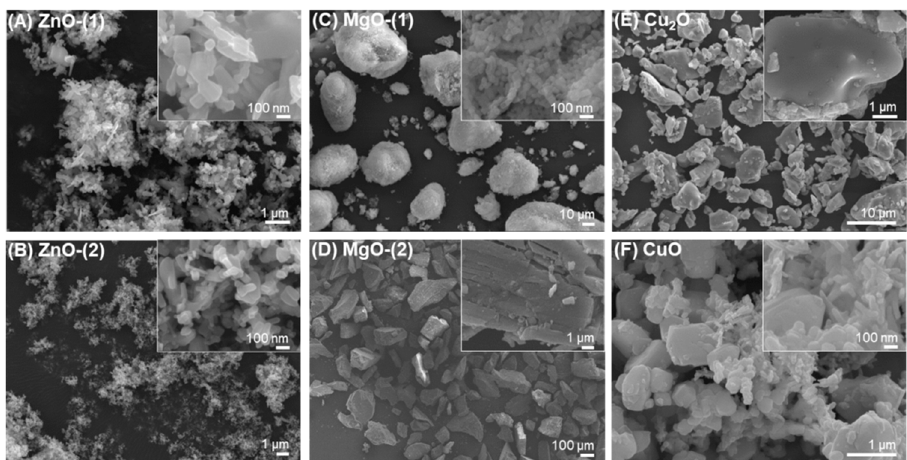
Figure 1. FE-SEM images of metal oxide (MO) particles: ( A ) ZnO-(1), ( B ) ZnO-(2), ( C ) MgO-(1), ( D ) MgO-(2), ( E ) Cu 2 O, and ( F ) CuO.